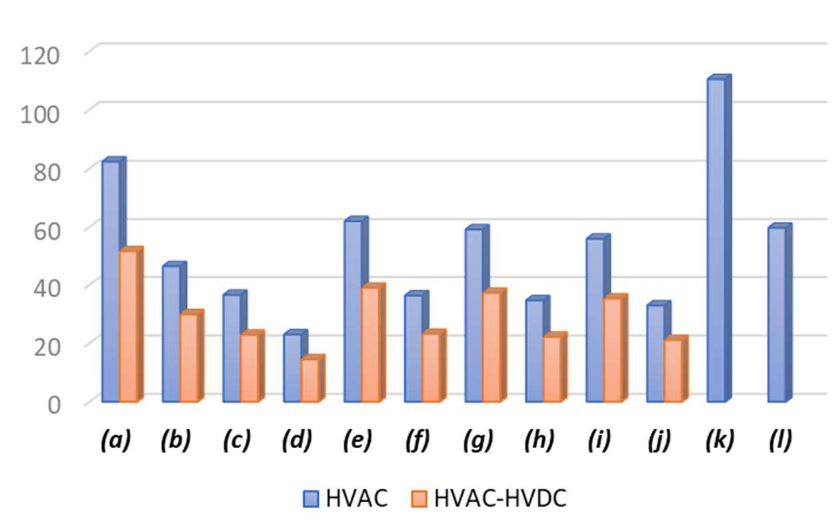
Figure 4. Number of deaths (kpers).